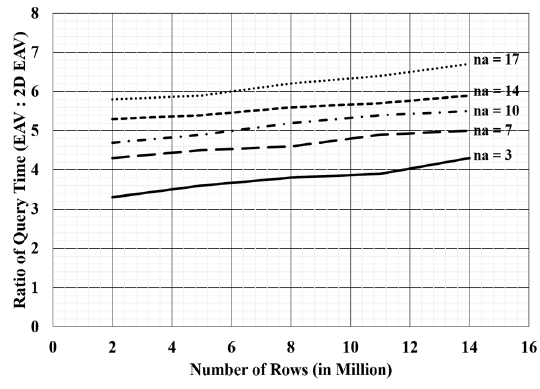
Figure 7. Selection operation results.